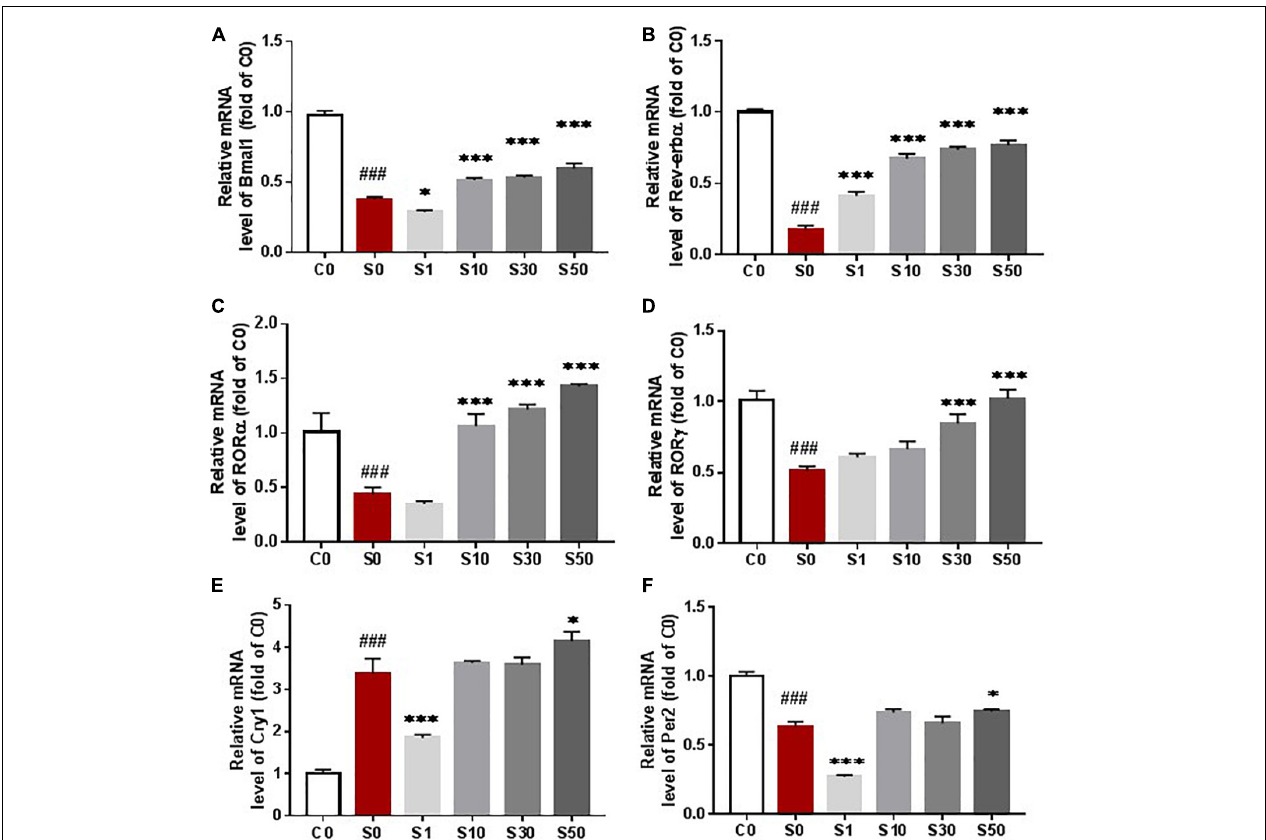
FIGURE 6 | Nobiletin (NOB) reversed the decrease of clock gene expression induced by surgery under anesthesia. NOB dose-dependently reverse the decrease of Bmal mRNA induced by surgery under anesthesia at dose 10, 30 and 50 mg/kg (A) . NOB also reversed the mRNA decrease of Nrldl (B) , RORa (C) and ROR γ (D) at dose of 10, 30 and 50 mg/kg (C) . NOB did not influence cryl (E) or per2 (F) mRNA level with dose of 10, 30 and 50mg/kg. Prefrontal cortex were collected to measure mRNA levels of Nrldl, Bmal1, ROR α , ROR γ , Per2 and Cryl by qRT-PCR assay. C0: control group without surgery; S0: surgery group with vehicle pretreatment; SI, S10, S30, S50: surgery group with NOB 1,10, 30, 50mg/kg pretreatment; mRNA levels were normalized to C0. # P < 0.05, ## P < 0.01, ### P < 0.001, n = 6, compared with the C0 group. * P < 0.05, ** P < 0.01, *** P < 0.001, n = 6, compared with the S0 group. Results were presented as means ±